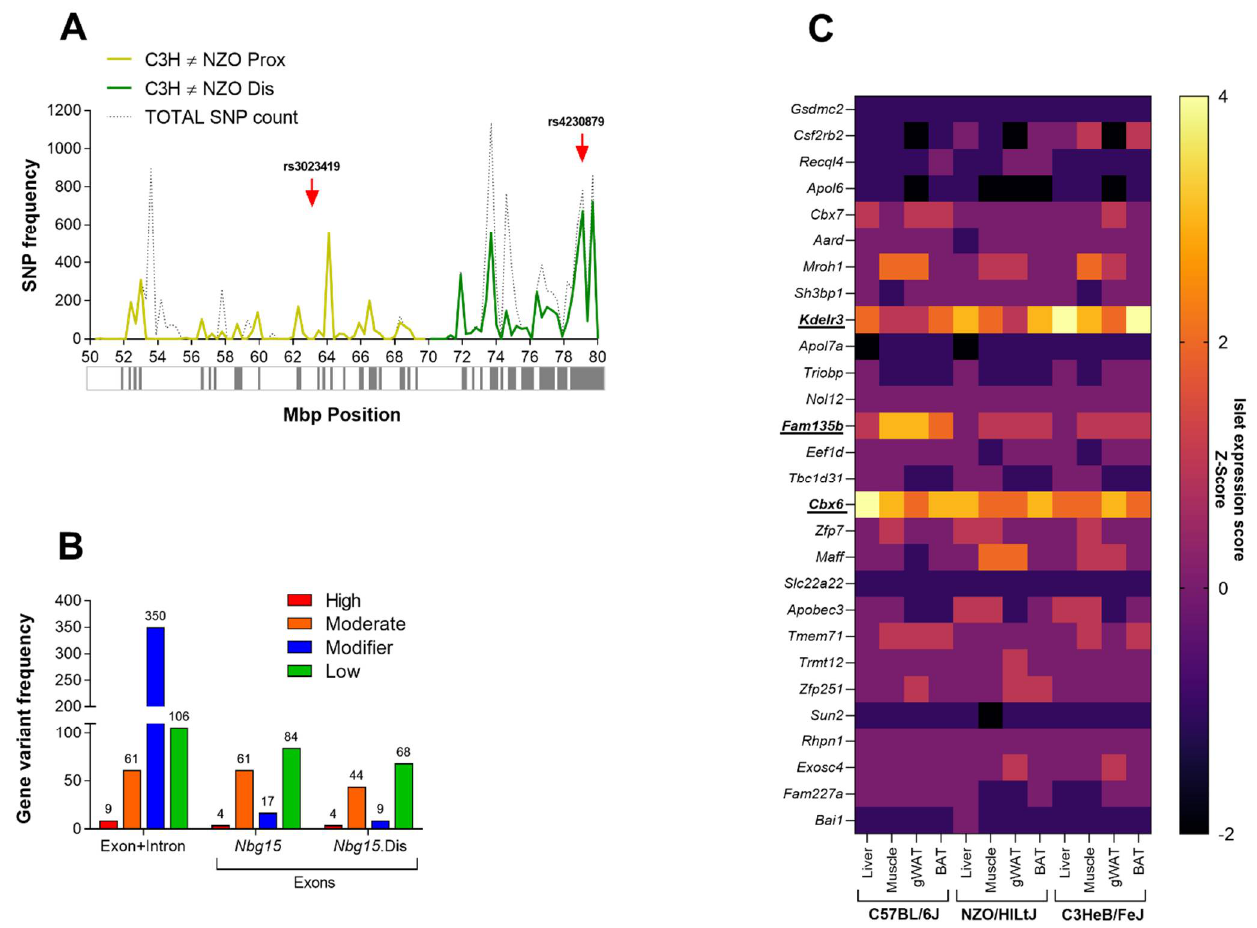
Figure 5. Combined approaches successfully identified potential causative genes underlying the Nbg15dis sublocus. Identification of C3H polymorphic regions underlying the Nbg15 sub-loci ( A ), variant effect prediction analysis (VEP) of identified non-IBD SNPs ( B ) and heatmap of islet specific genes containing non-IBD SNPs predicted to affect protein effectiveness selected via the VEP analysis and the SIFT code under 0.5. Polymorphic regions were calculated using Genome Reference Consortium